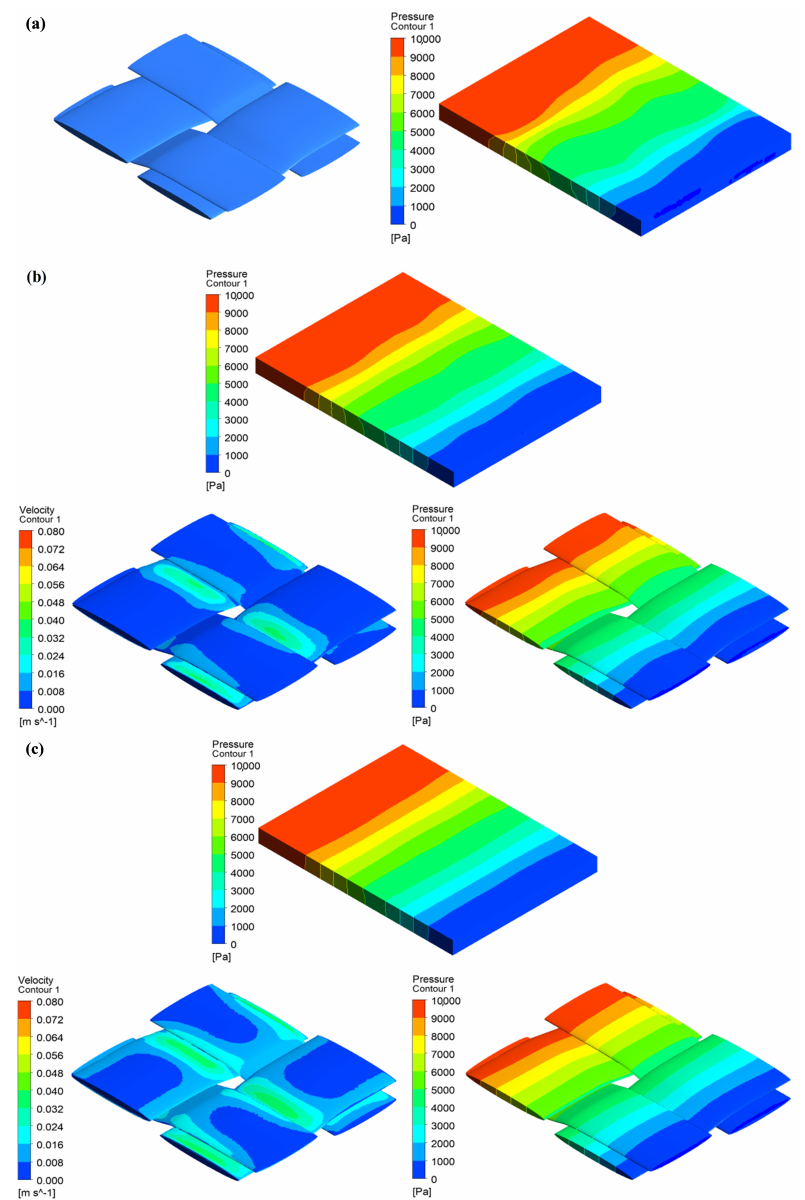
Figure 8. Pressure and velocity contours for channel flows in single- and dual-scale porous media for a unit cell with an inter-tow porosity value φ s = 44% and local curvature of tows varied in the range of 0 ≤ θ ≤ 10.2: ( a ) impermeable tows, ( b ) permeable tows with K t (cid:107) = 6.8 × 10 − 11 , K t ⊥ = 3.5 × 10 − 11 ( c ) permeable tows with K t (cid:107) = 6.8 × 10 − 10 , K t ⊥ = 3.5 × 10 − 10